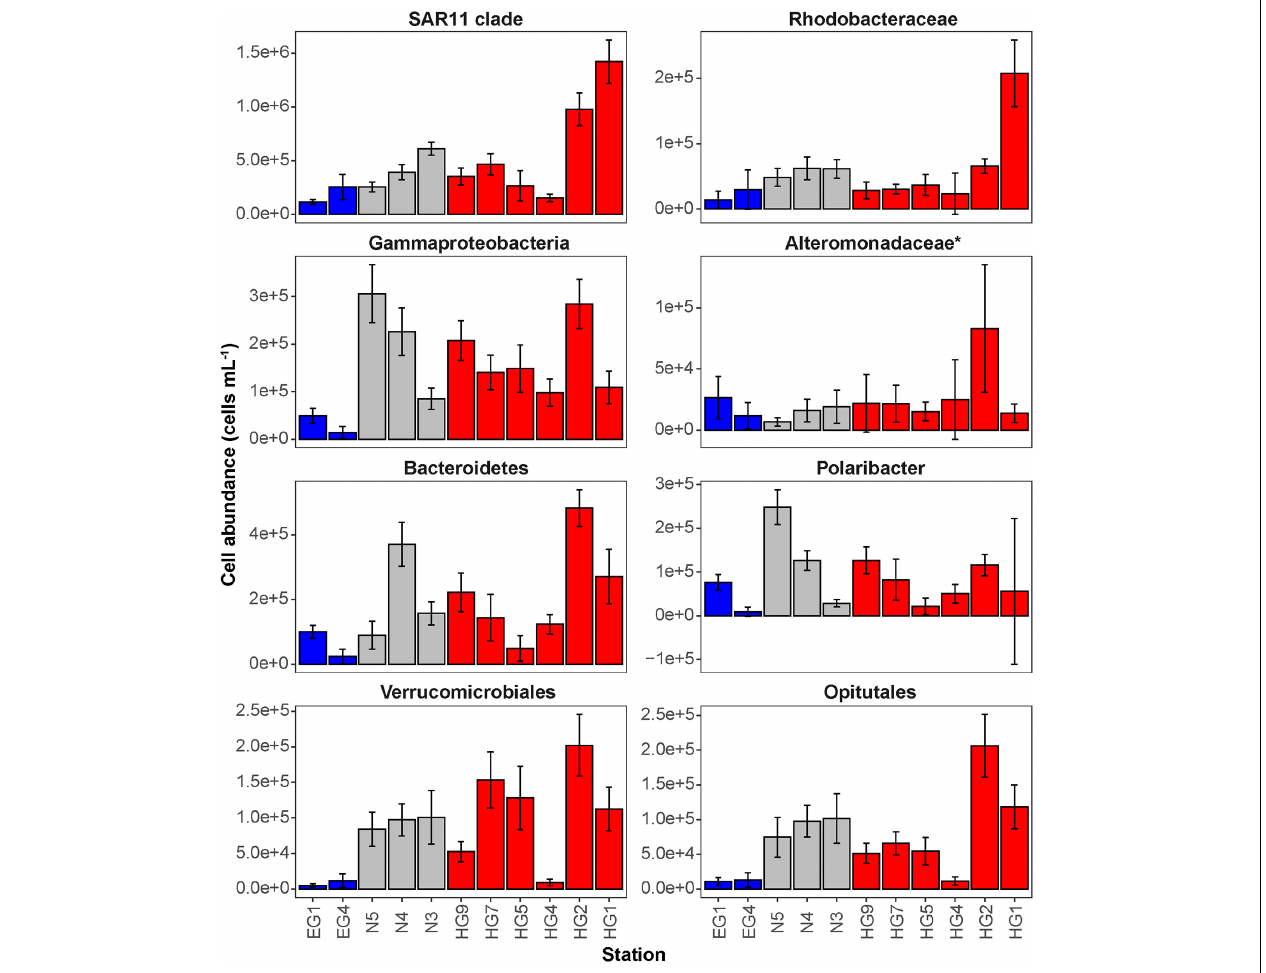
FIGURE 3 | Mean cell abundances of selected taxonomic groups at each station in surface (15–30 m) waters (cells mL - 1 ). The different regions are indicated by color: ice-covered EGC–blue, ice-margin N–gray, ice-free WSC–red.